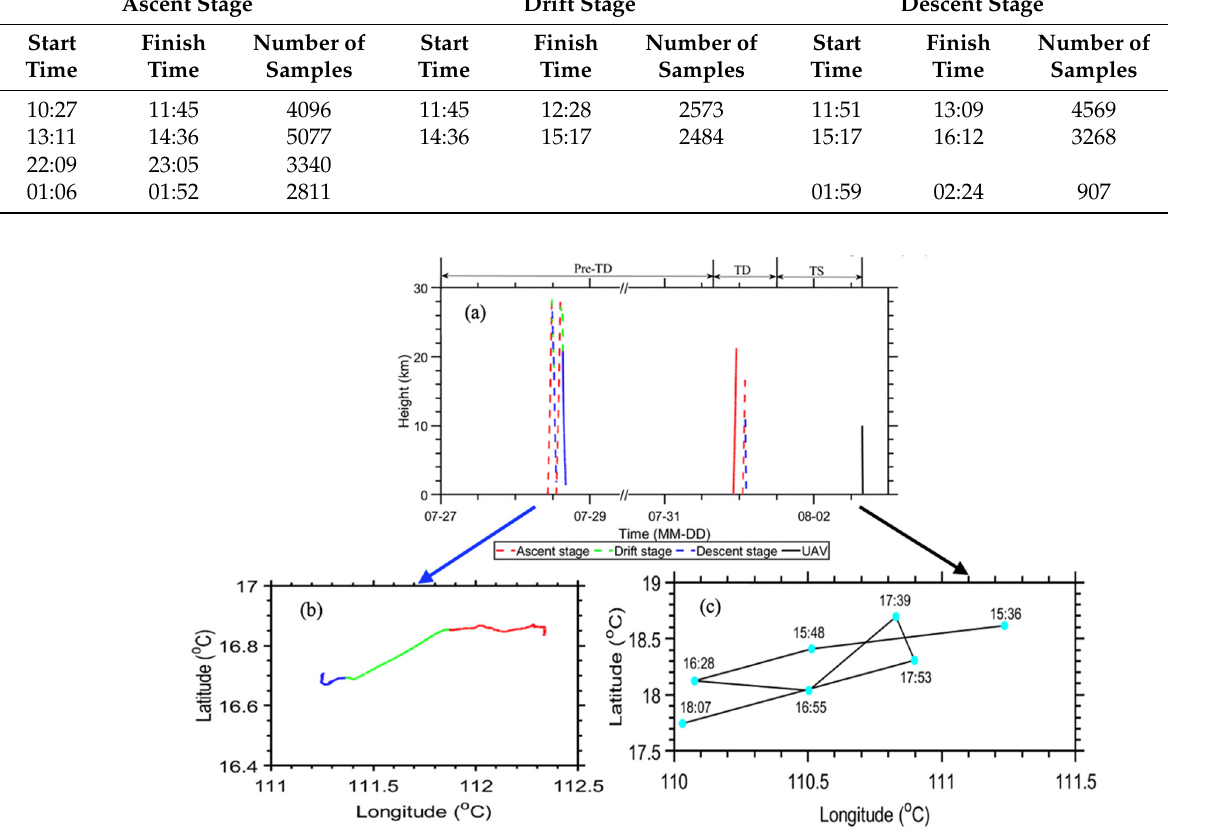
Table 2. The information on dropsonde measurements conducted from the unmanned aerial vehicle on 02 August 2020. Note that all times are in LST.